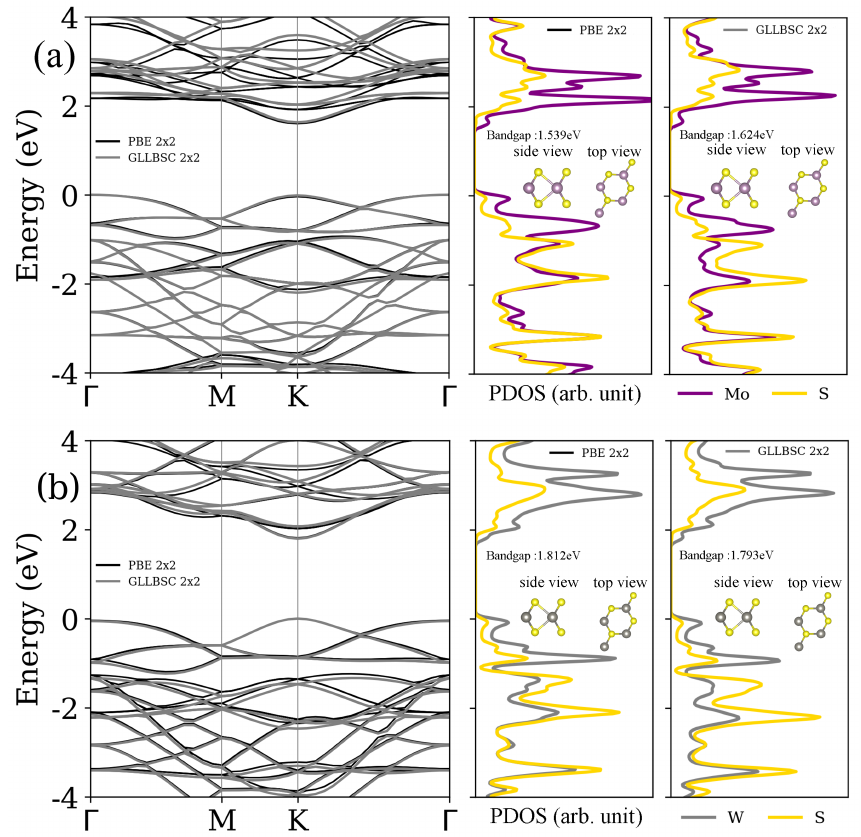
Figure 4. Band structures and projected density of states (PDOS) as calculated for ( a ) MoS 2 and ( b ) WS 2